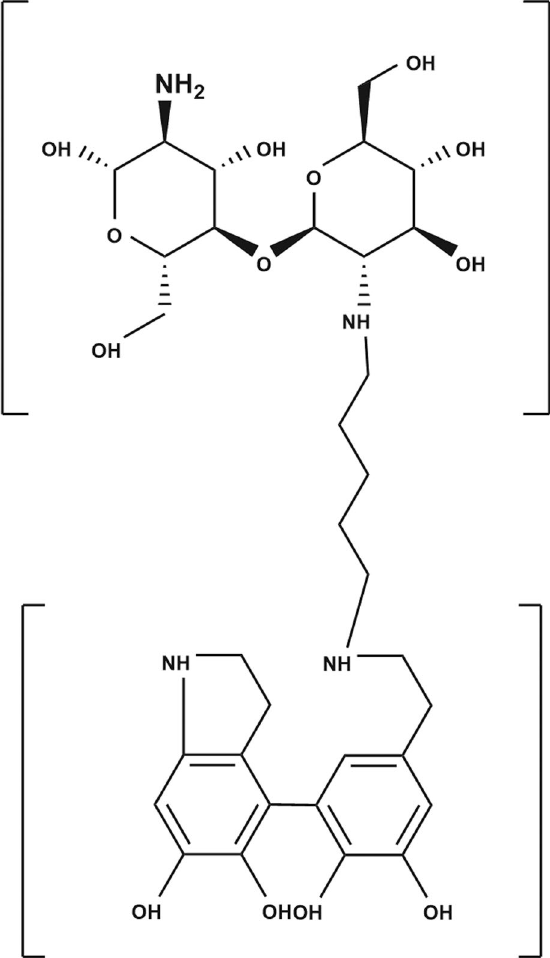
Fig. 11 The schematic diagram of the molecular structure of glutar- aldehyde linked-PDA-chitosan